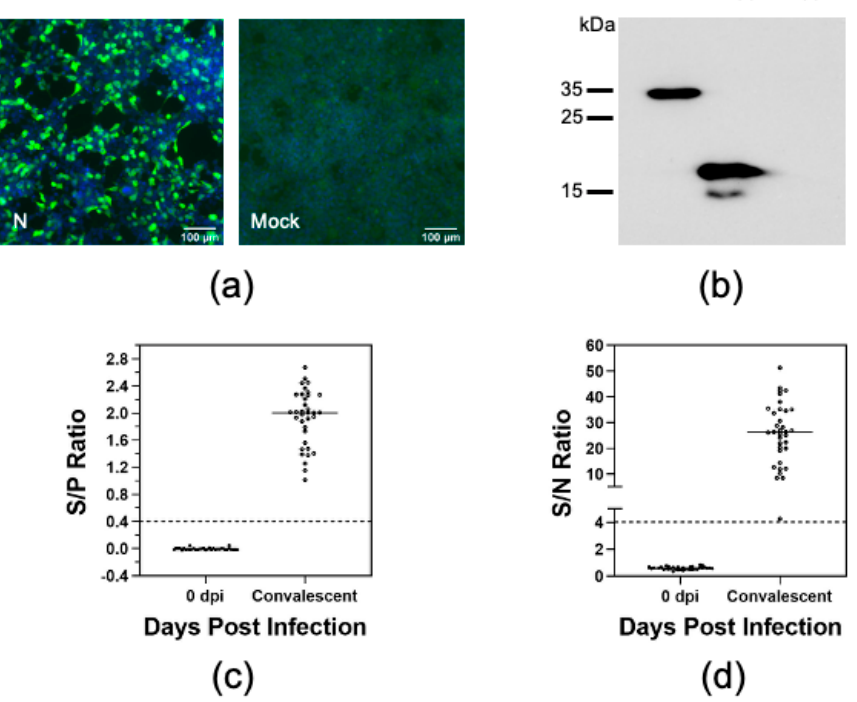
2 Figure 2. Optimization of the LIPS with N protein. ( a ) HEK-293T cells were transfected with plasmids encoding Nluc-tagged N protein (N) or Nluc only. At 60 h after transfection, cells were fixed and subjected to indirect immunofluorescence assay (IFA) using a monoclonal antibody specific to Nluc protein. The cell nuclear was stained with DAPI (blue). ( b ) HEK-293T cells were transfected as described previously. At 60 h post-transfection, cells were harvested and lysed in RIPA bu ff er and subjected to immunoblotting analysis using a monoclonal antibody specific to Nluc protein. ( c ) Serum samples collected from 35 pigs experimentally infected with the PRRSV-01 or FL12 and their derivative mutants at 0 dpi and 42 dpi. Serological status of the serum samples as determined by the IDEXX ELISA. Data are expressed as the sample to positive (S / P) ratios. The horizontal dotted line at S / P = 0.4 indicates the cuto ff of this assay. ( d ) Immunoreactivity of the serum samples were measured against Nluc-tagged N protein as described in Materials and Method. Fetal bovine serum (FBS) was used as negative control. Data are expressed as sample to negative (S / N) ratios. The dotted line at S / N = 4.02 indicates the cuto ff of the